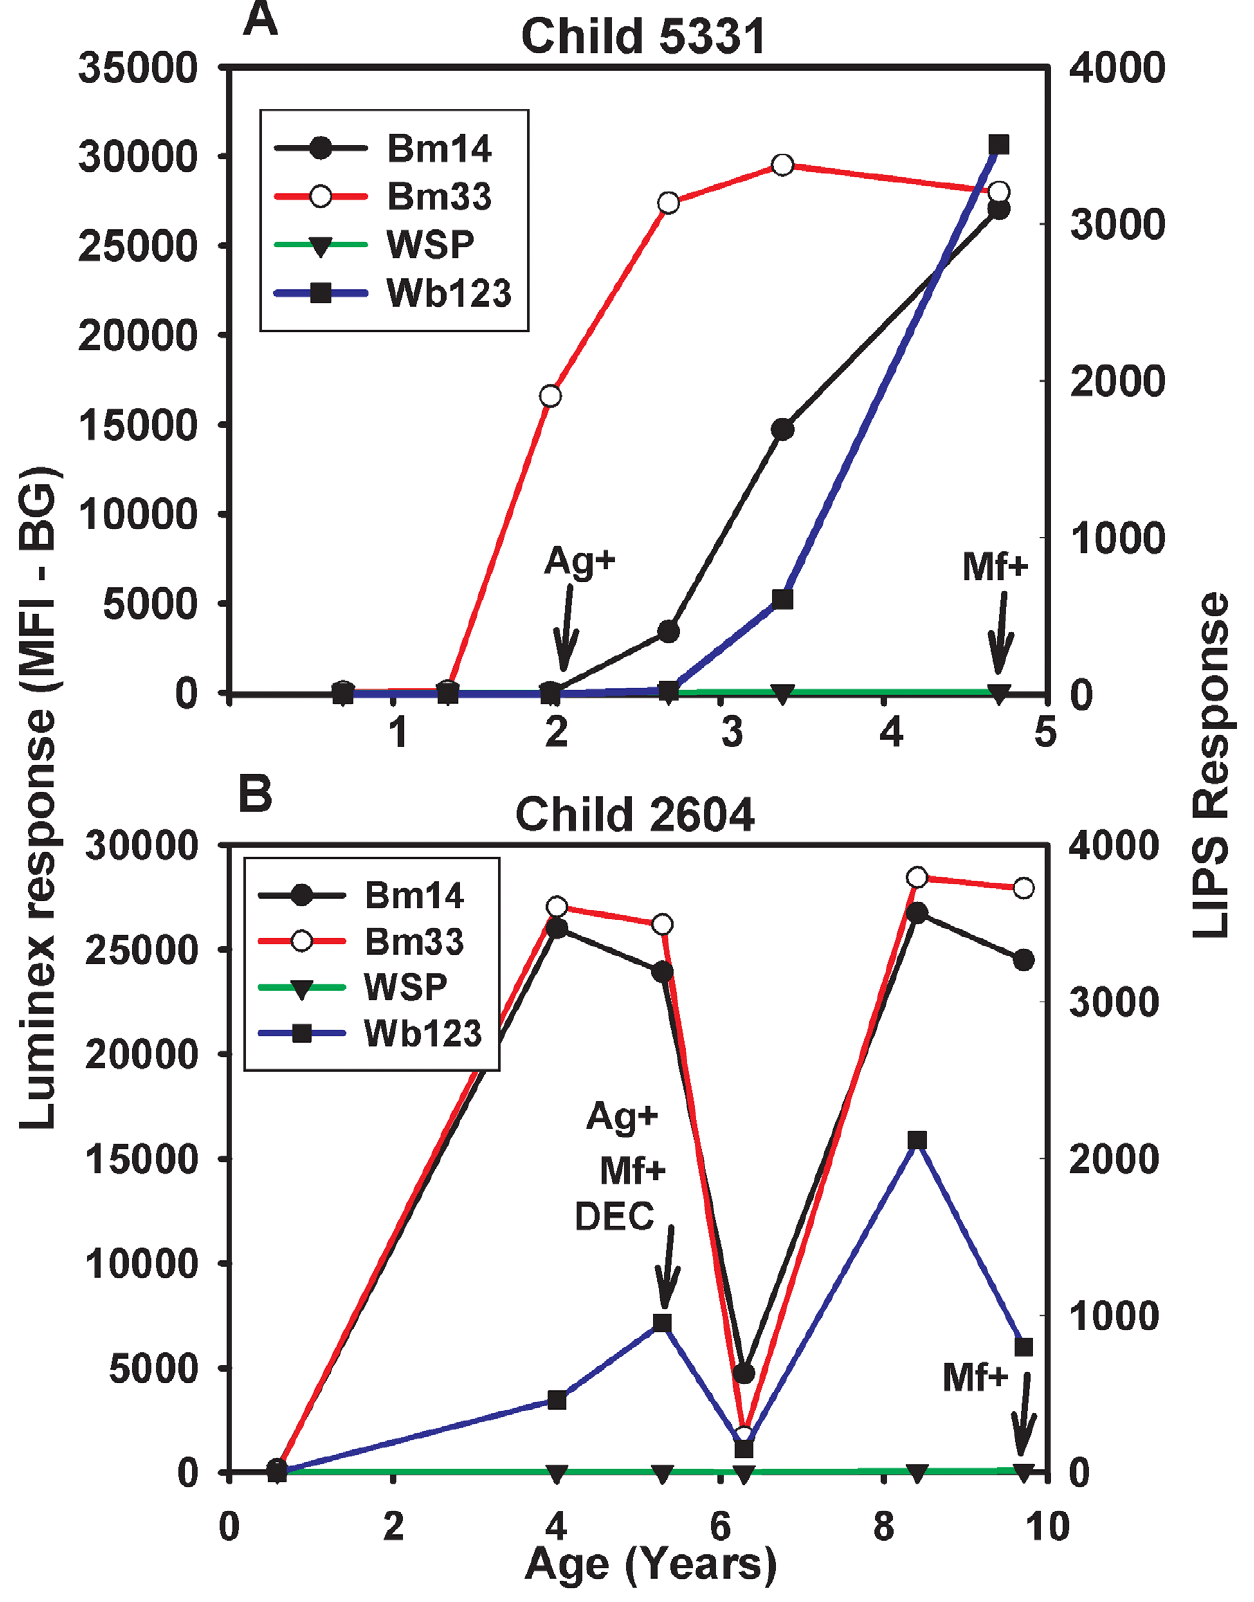
Figure 2. Representative antibody profiles. Antibody responses to Wb123, Bm14, BM33 and WSP were monitored in serum samples for child # 5331 (panel A) and child # 2604 (panel B). collected over time. First detection of antigenemia (by Og4C3 ELISA) and microfilaremia are indicated. Microfilaremic children were treated with DEC. doi:10.1371/journal.pntd.0001941.g002 PLOS Neglected Tropical Diseases |